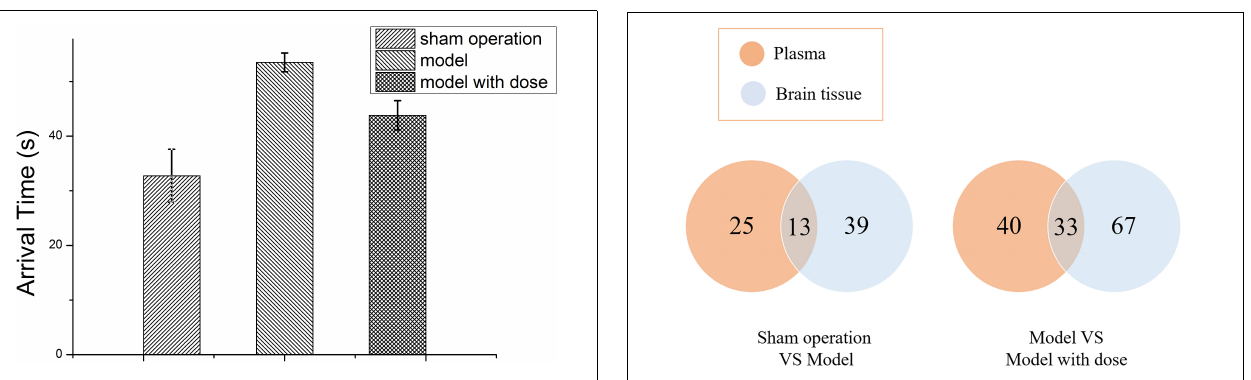
FIGURE 1 | Bar chart of the water maze data. FIGURE 2 | A Venn plot of blood biomarkers and the brain